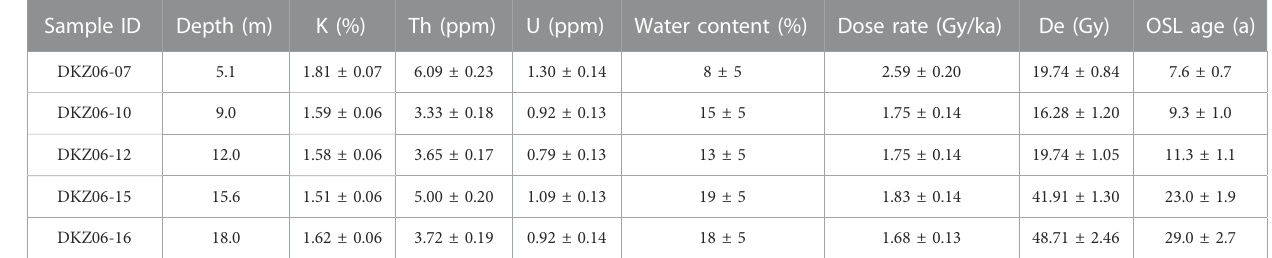
TABLE 1 Summary of dosimetry and OSL ages at core